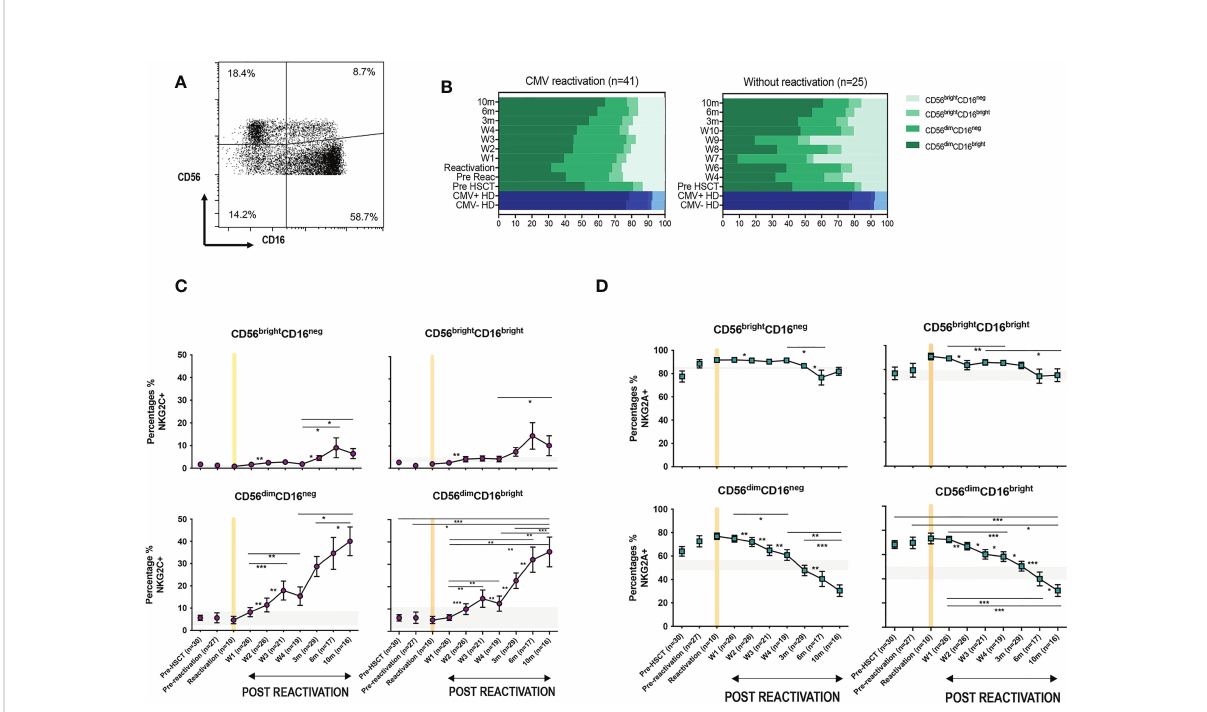
FIGURE 3 CMV reactivation leads to increased expression of NKG2C+ on all CD56 dim and CD56 bright subpopulations. (A) Gating to show separation of four NK subsets according to CD16 and CD56 expression. (B) Relative distribution of NK subsets in patients following CMV reactivation (left) and those without reactivation (right) Blue bars represent the NK subsets in CMV+ and CMV- HDs. (C) Relative NKG2C expression on NK subsets following CMV reactivation. (D) Relative NKG2A expression on NK subsets following CMV reactivation. Grey lines represent the range of NKG2C + and NKG2A+ NK cells in HDs. (*p<0.05, **p<0.01, ***P<0.001; Wilcoxon sign rank test for matched time